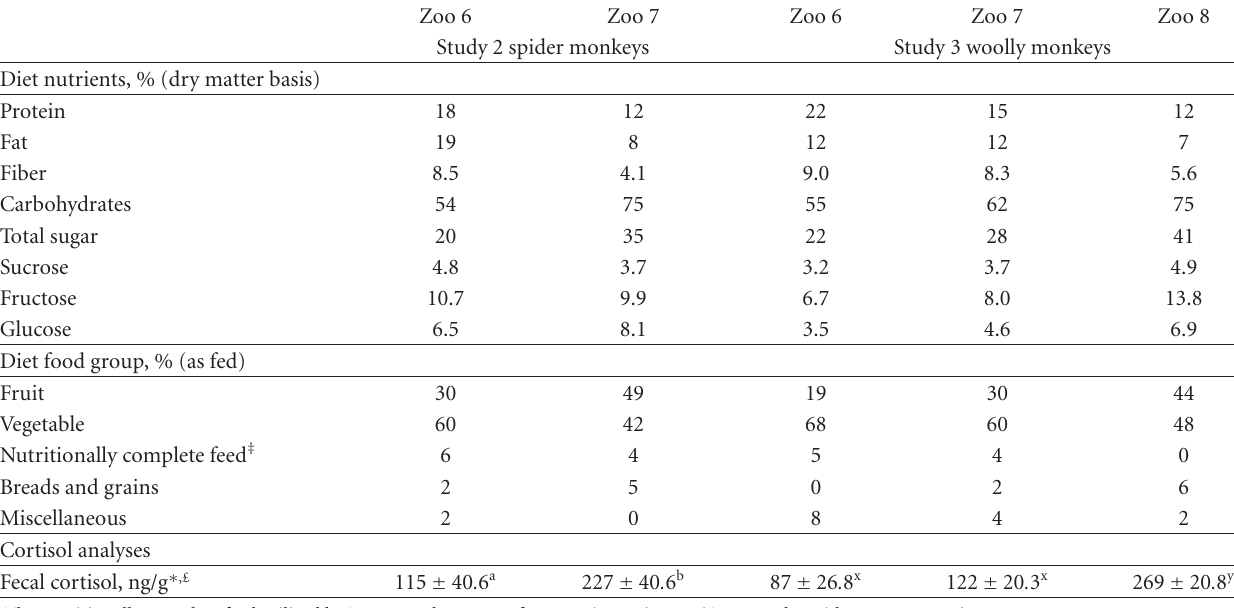
Table 3: Spider and woolly monkeys diet nutrient analyses, food group percentages, and fecal cortisol concentrations ( ± SEM) from three zoological institutions in